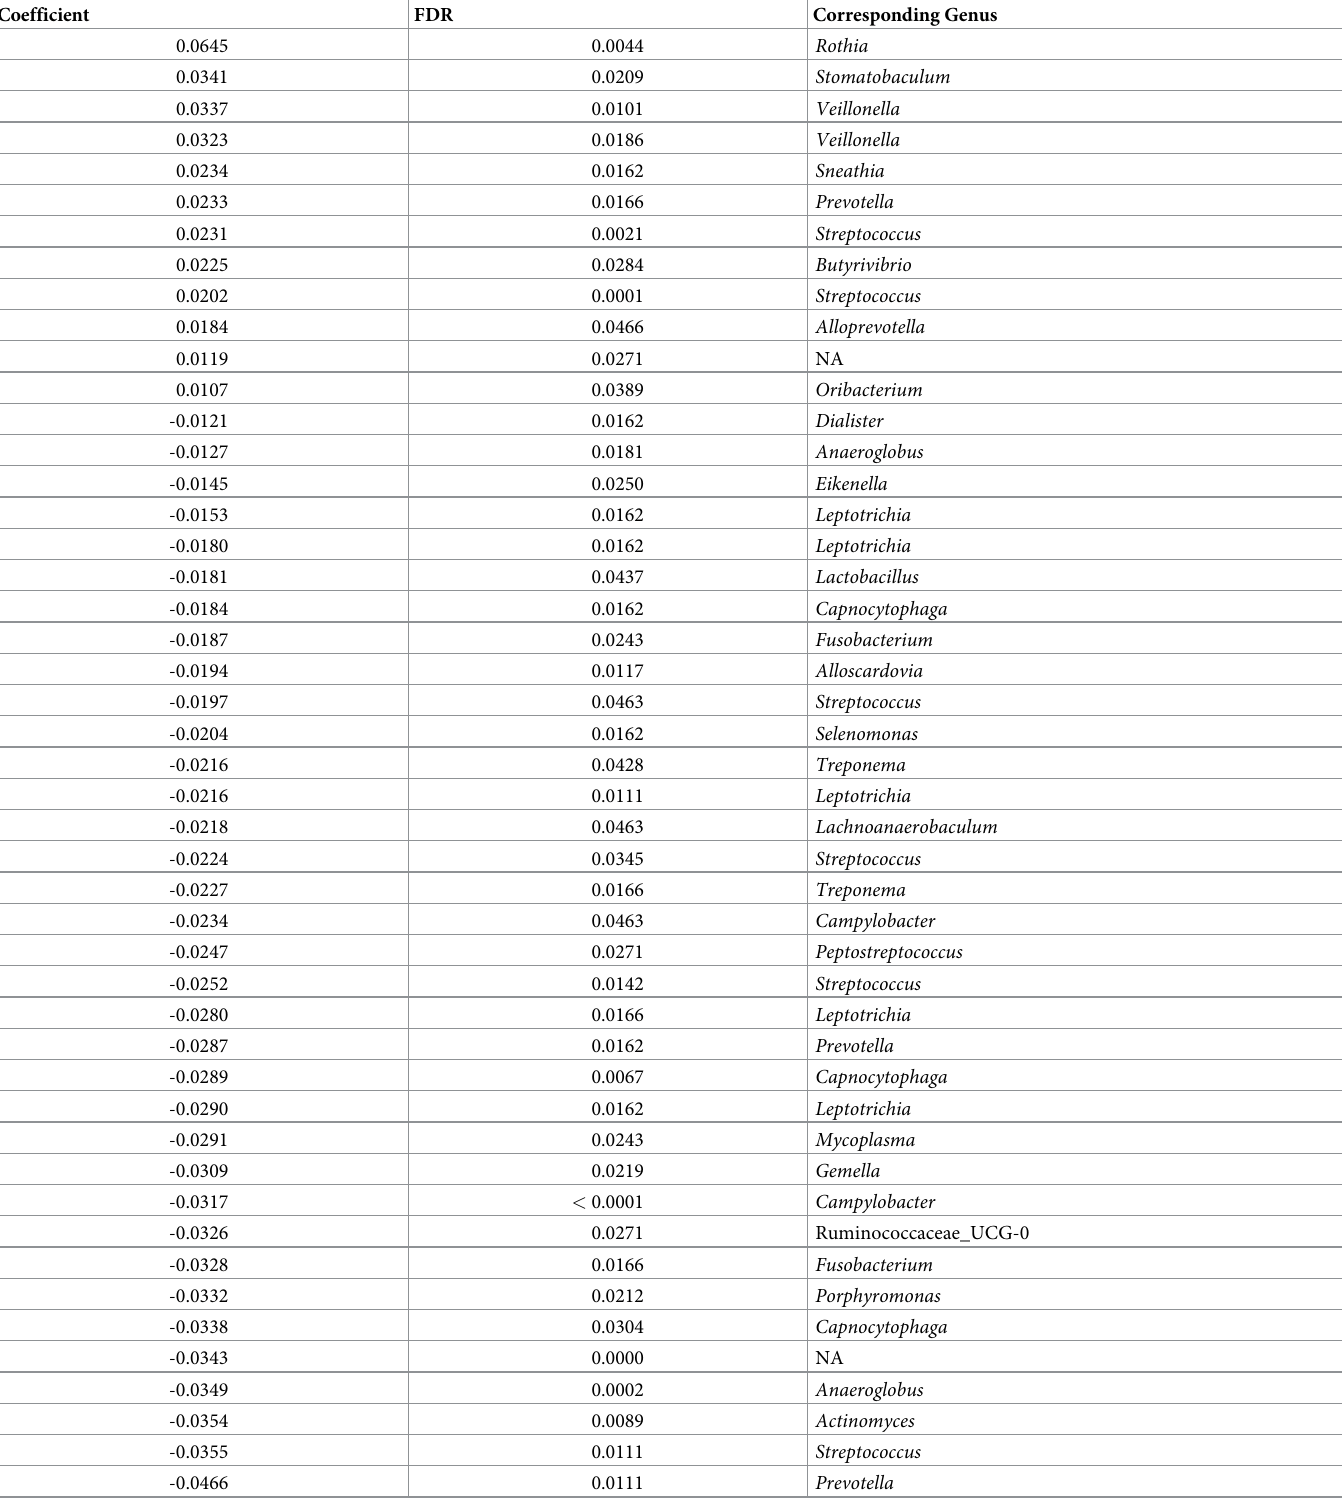
Table 5. Sputum taxa associated with lung obstruction